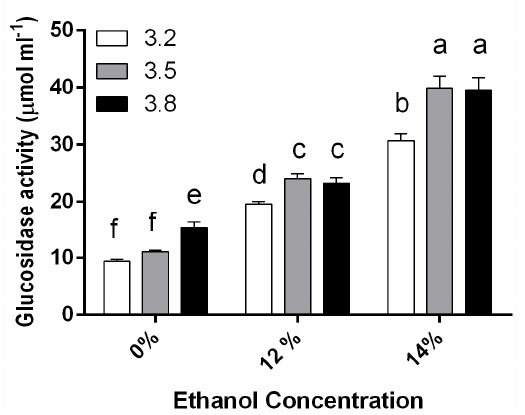
Figure 4. β -glucosidase activity of a commercial enzyme from fungal origin in synthetic wine with different ethanol concentrations (0%, 12%, and 14%) and at different pH values (white bars 3.2, gray bars 3.5, and black bars 3.8) for 15 days at 21 °C. Different letters (a, b, c, d, e, f) represent groups with significant differences ( p < 0.05). The statistical analysis was done with ANOVA and posterior Tukey test.